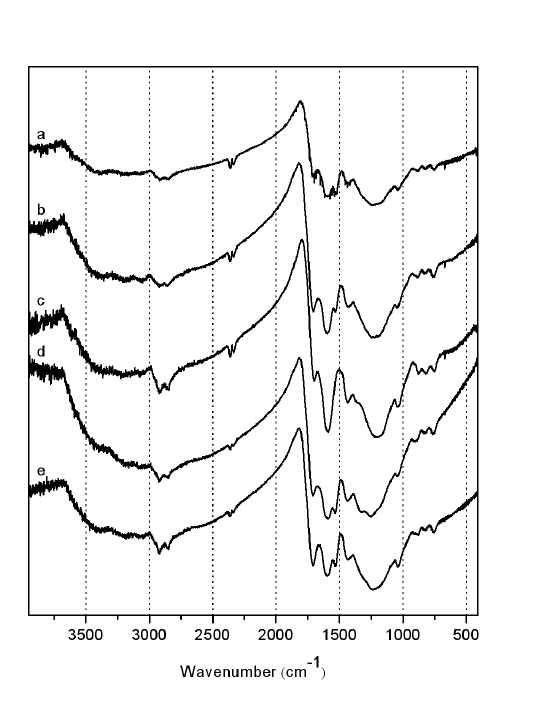
Fig. 4 FTIR spectra of solid products of ex- traction with CH 2 Cl 2 : (a) dpf, (b) O 2 /125,